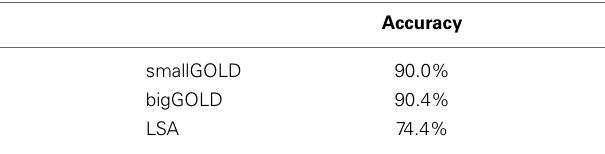
Percentages shown in red are the correct